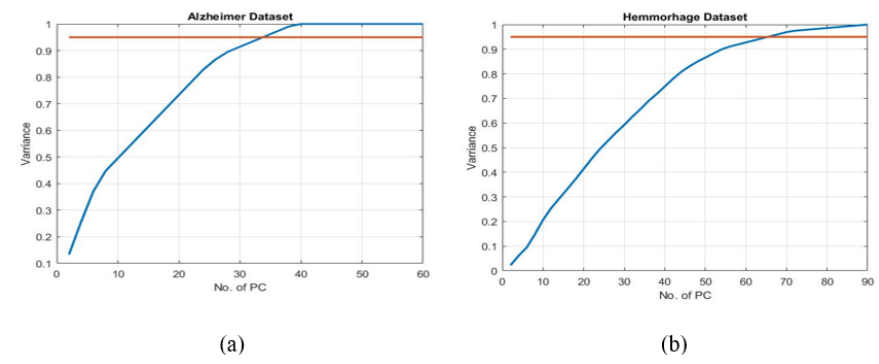
Figure 7. Variance (%) in respect of the number of PCs for both ( a ) Alzheimer’s and ( b ) Hemorrhage dataset.